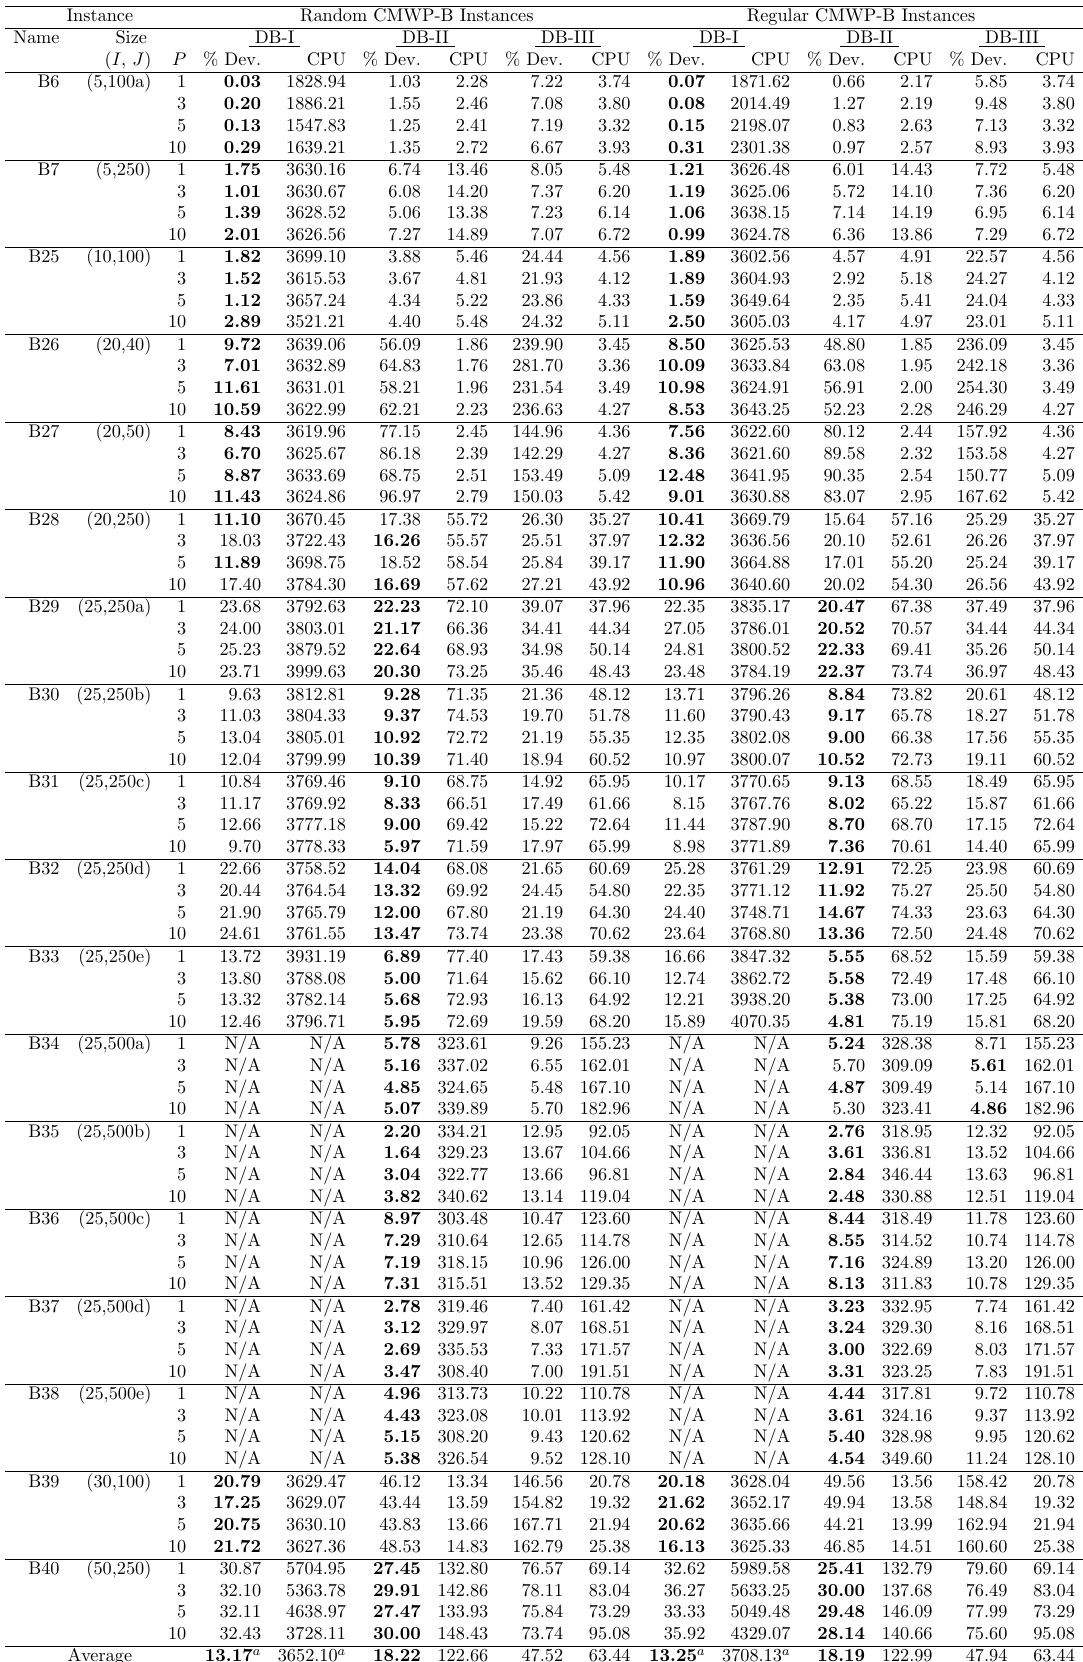
Table 4. The performance of the DB heuristics over large sized random and regular CMWP-B instances based on Boyacı [48]